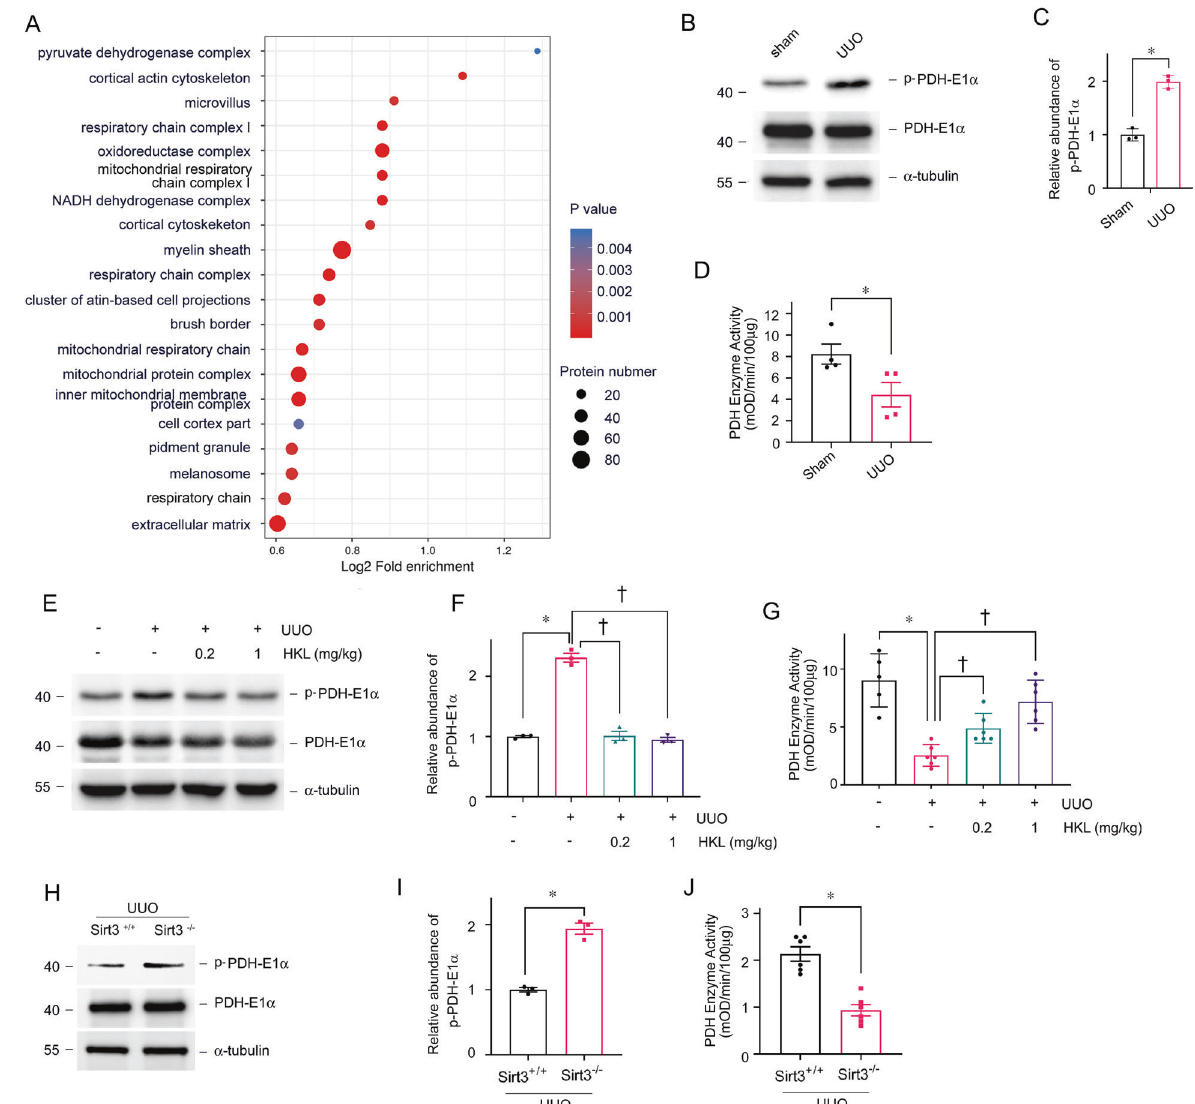
Fig. 6 Acetylation of PDHE1 α is increased in tubules from fi brotic kidneys. A Cellular component GO enrichment analysis of upregulated acetylated proteins in tubules separated from UUO and sham-operated mice. Bubble chart shows top 20 signi fi cantly enriched terms (vertical axis, functional category; horizontal axis, Log2 transformed ratio of upregulated acetylated proteins to identi fi ed proteins. Colored circles indicate signi fi cant p values; circle size indicates a number of differential proteins in terms. B , C Western blots of phosphorylated PDHE1 α and total PDHE1 α expression in tubules from UUO and sham-operated mice on POD 1. PDHE1 α served as the standard (* P < 0.05; n = 3). D Enzyme activity of PDH in tubular mitochondria from UUO and sham-operated mice on POD 1 (* P < 0.05 vs. sham; n = 4); E , F Western blots of phosphorylated PDHE1 α and total PDHE1 α expression in tubules from UUO and sham-operated mice injected with or without HKL on POD 1. PDHE1 α served as the standard (* P < 0.05, † P < 0.05; n = 3). G Enzyme activity of PDH in tubular mitochondria from UUO and sham-operated mice injected with or without HKL on POD 1. (* P < 0.05, † P < 0.05; n = 5 – 6). H , I Western blots of phosphorylated PDHE1 α and total PDHE1 α expression in tubules from Sirt3 KO and WT mice with UUO on POD 1. PDHE1 α served as the standard (* P < 0.05; n = 3). J Enzyme activity of PDH in tubular mitochondria from Sirt3 KO and WT mice with UUO on POD 1. (* P < 0.05; n =